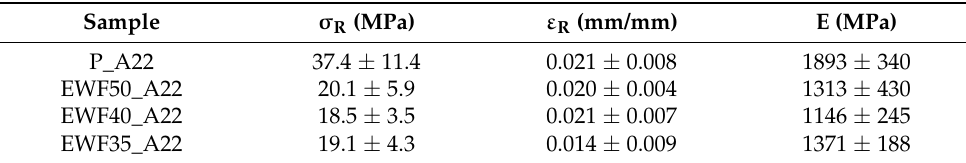
Figure 10. Stress–strain curves from flexural tests of cured blends at different EWF contents. Table 3. Flexural properties of cured blends at different EWF contents.